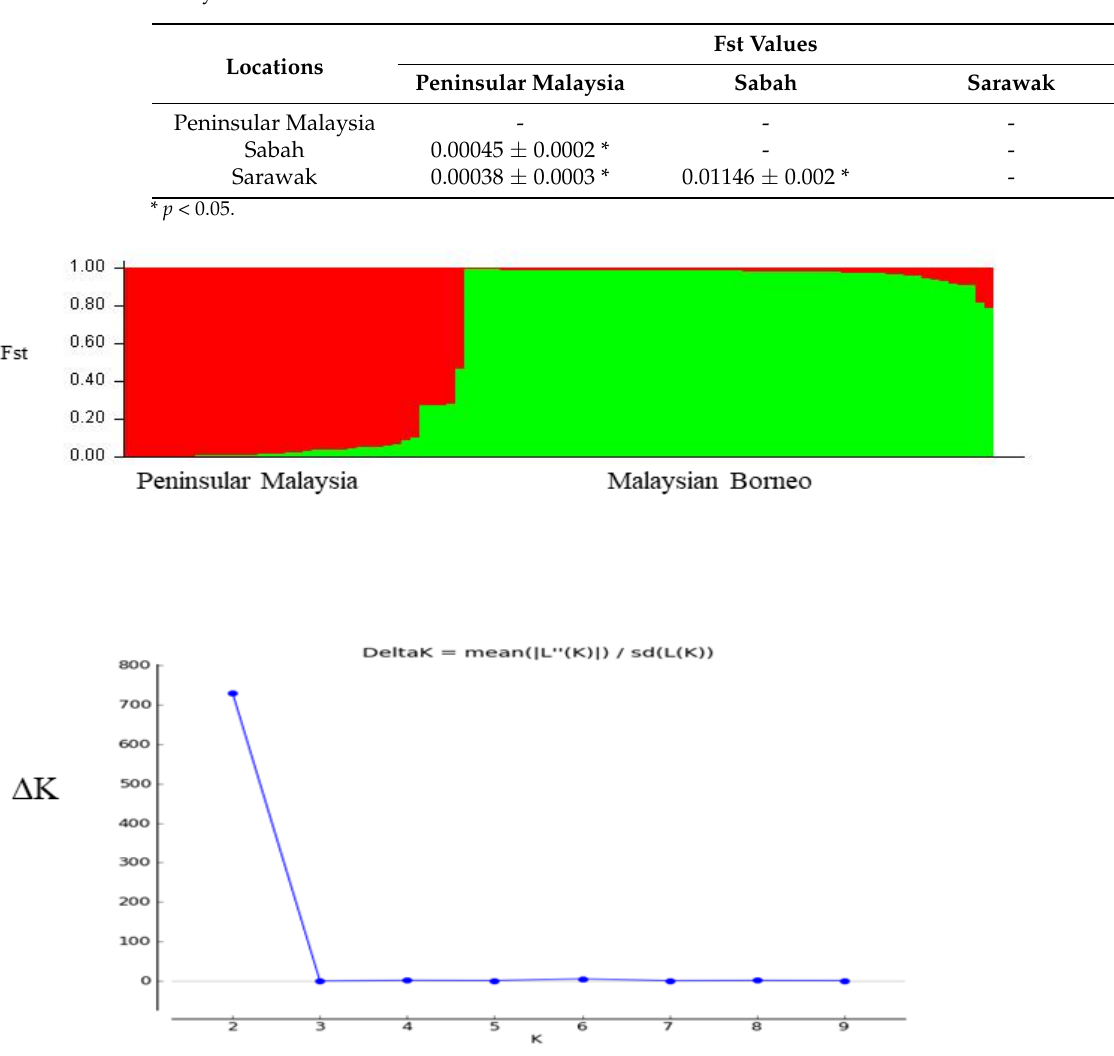
Table 2. Population differentiation values (FST) for PkTRAMP from Peninsular Malaysia and Malaysian Borneo.